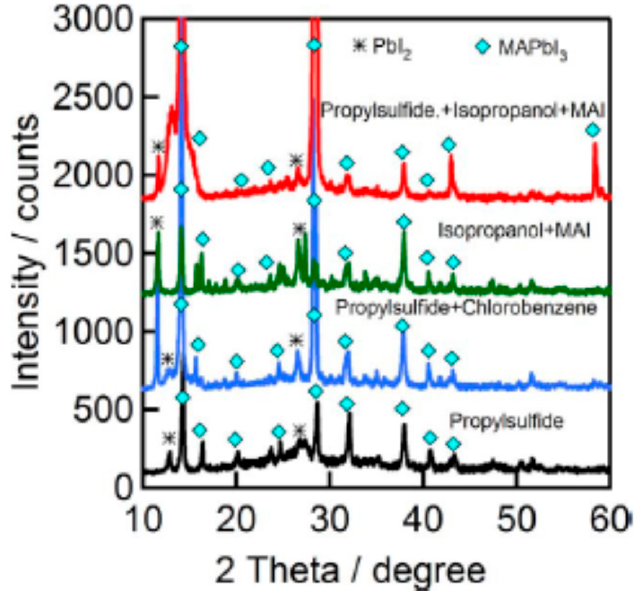
Figure 6. XRD patterns of FTO/bl-TiO 2 /m-TiO 2 /CH3NH3PbI3/CuSCN film, CuSCN was prepared using different solvents, S1, S2, S3 and S4, deposited by doctor blading method under 80 ◦ C at air atmosphere. The peaks corresponding PbI2 and MAPbI3 are labelled by asterisk the (*) and ( ♦ ), respectively. Reproduced with permission from Reference [53]. Elsevier 2017.